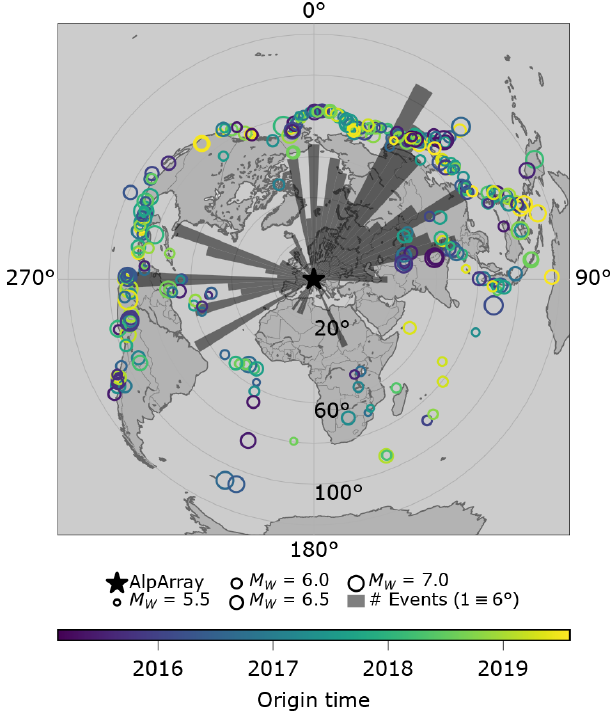
Figure 2. Event distribution of the high-frequency dataset db 0 . 5 . Size of circles correlates with moment magnitude, colour with ori- gin time. Histogram shows number of events binned in 5 ◦ bins az- imuthally. A bar height of 60 ◦ radial distance equals 10 events com- ing from that direction. The distribution is very irregular with most events located in the northeastern quadrant and in a western sec- tor. There are large gaps with few or no events especially from the southeast as well as from the northwest. Peak value is 18 events for the back-azimuth interval between 30 and 35 ◦